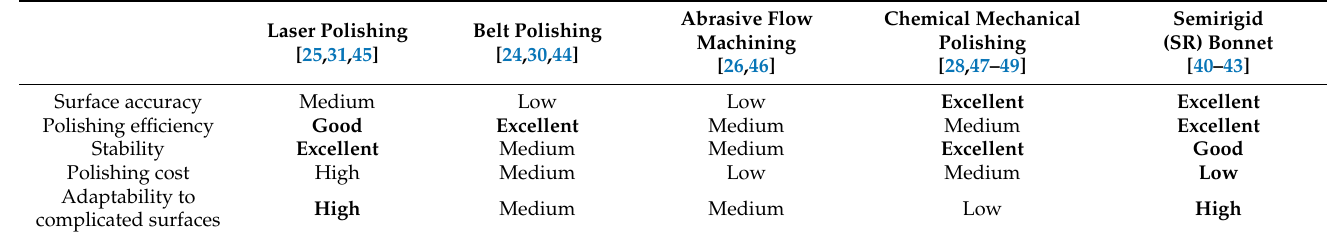
Table 5. General comparison between different tool types a,b,c